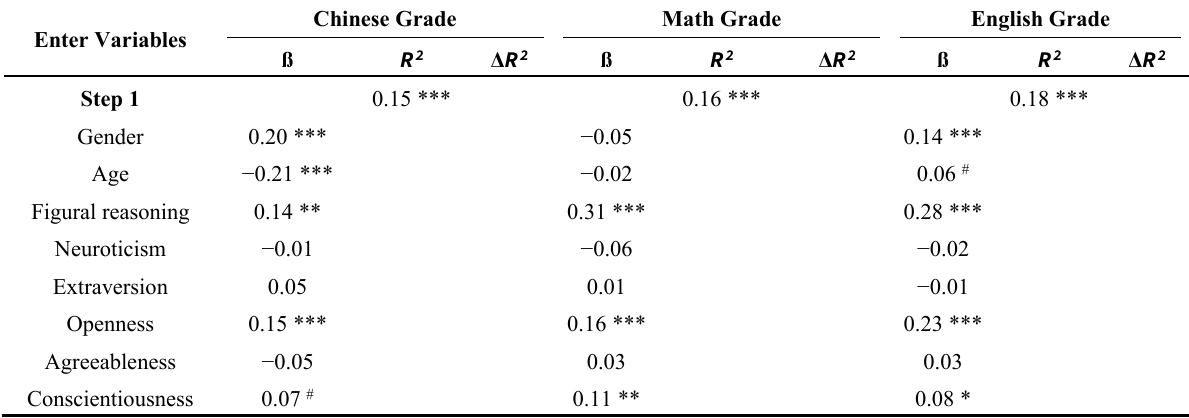
Table A. Prediction of scholastic performance in Chinese, Math, and English: results from hierarchical regression